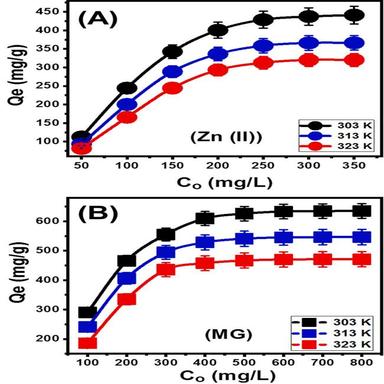
Changes in the adsorption capacities (Qe) of Mg-doped hydroxyapatite nanofibers for (A) Zn2+ ions and (B) malachite green (MG) dye with initial concentration (C0) at 303, 311, and 323 K.